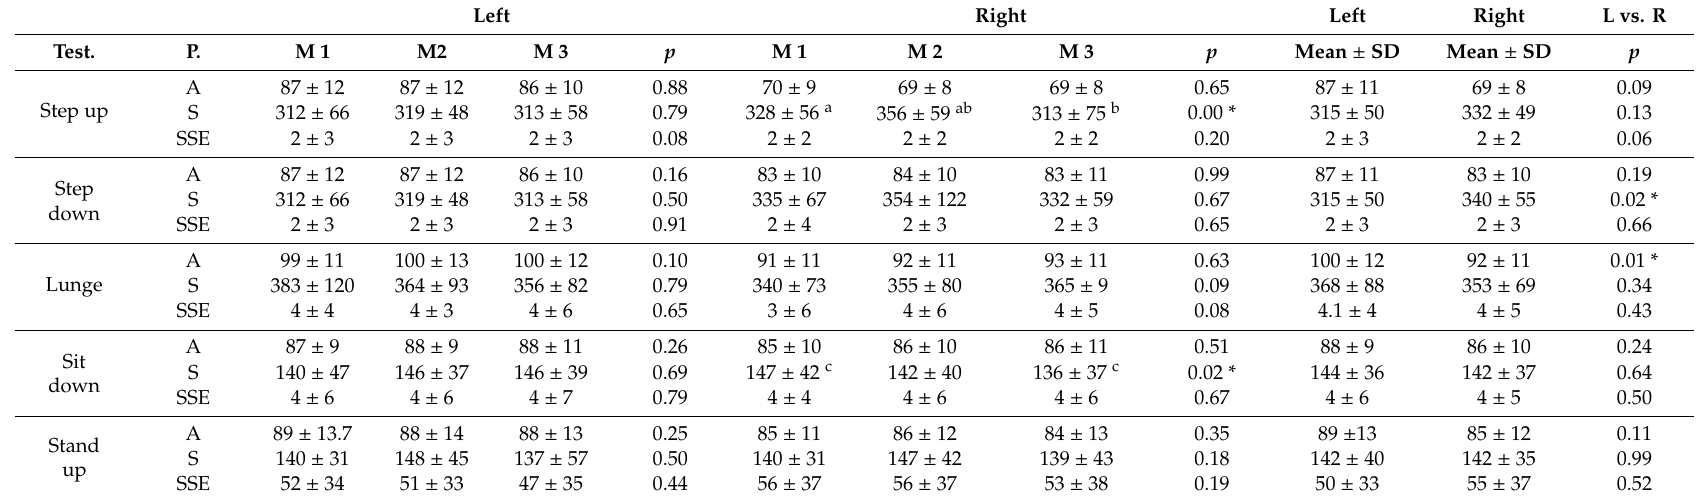
Table 2. Measurement results of selected, complex movement exercises: The range of motion, arbitrary movement speed, and potential deviations from correct movement trajectory (mean value ± SD). Left Right Left Right L vs. R